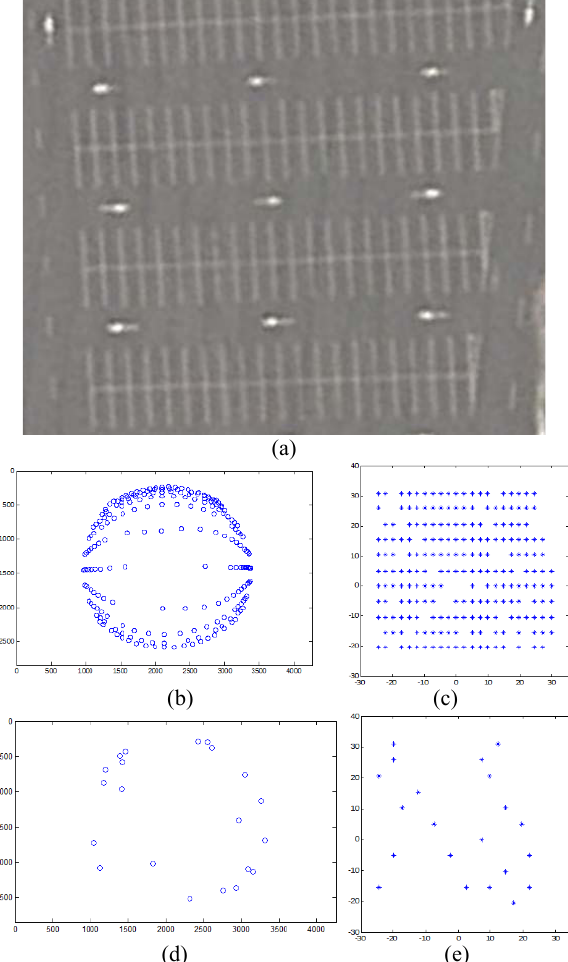
Figure 3: a) Aerial view of the test area; b) GCPs measured in the image; c) GCPs in the object space; (d) Check points measured in the image; e) Check points in the object space. Parameters of three different generic models were estimated and the residuals after projecting from the object to the image space were computed. RFM (Eq. 8) with 3rd and 4rd order polynomials and adjustment with φ -r polynomials (POL) were used. The residuals of these methods are plotted against the radius in Figures 4.a, 4.b and 4.c, respectively. The standard deviations of the residuals in the GCPs and in the Check Points are presented in Table